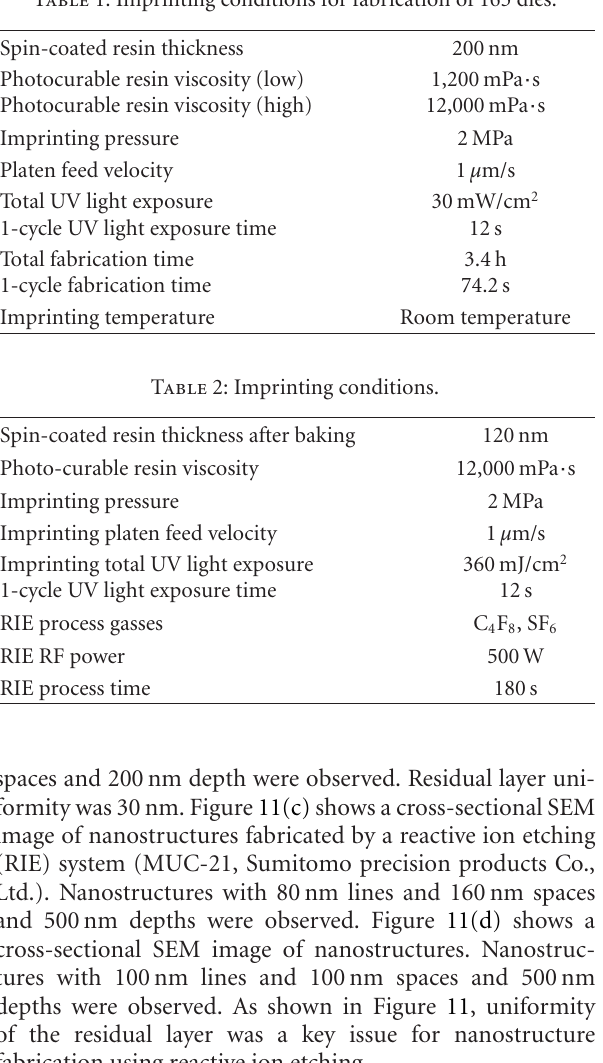
Table 1: Imprinting conditions for fabrication of 165 dies.